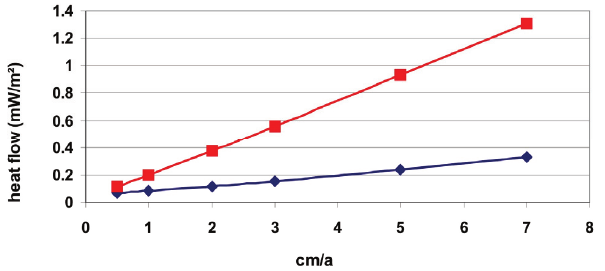
Fig. 6. Shown is the increase of heat flow (deep-seated background heat flow=60mWm − 2 ) as function of ascend rate of fluids over a depth interval of 1000m (blue) or 4000m (red) according to an an- alytical solution provided by Bredehoeft and Papadopoulos (1965).